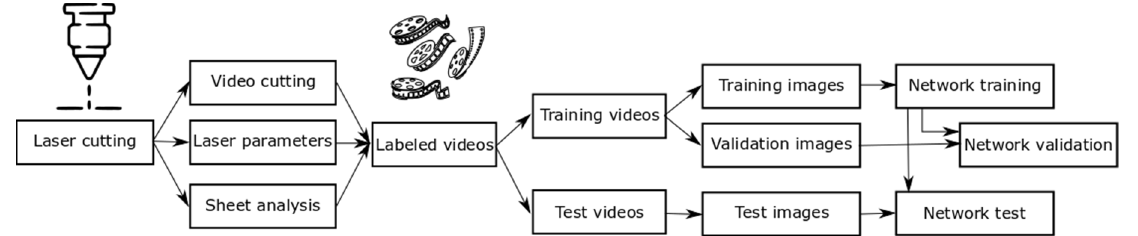
Figure 4. Experimental design of image provisions and evaluations.